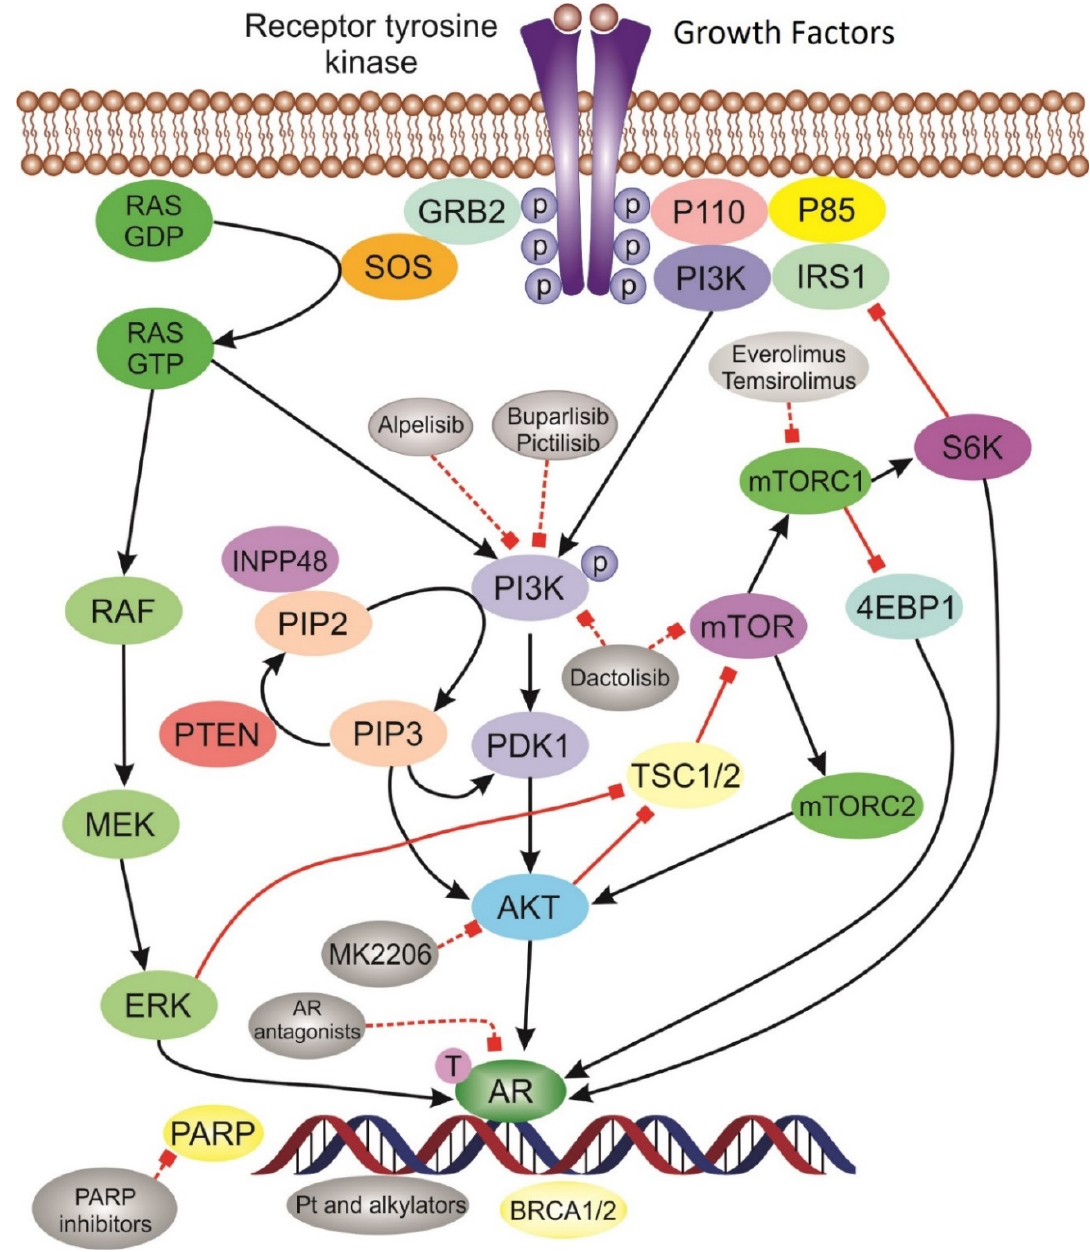
Figure 2. Schematic of the most relevant molecular pathways and targeted agents in TNBC. Tyrosine kinase receptor is activated upon binding of growth factors leading to activation of signaling pathways. PI3K / AKT pathway and inhibitor drugs: Phosphorylated PI3K activate AKT. The activation of AKT triggers downstream protein complexes mTORC activation that initiate gene transcription and promote cell growth. AR pathway is activated in LAR subtype tumors. Platinum drugs act through DNA damaging mechanism. PARP inhibitors induce “synthetic lethality” in BRCA deficient